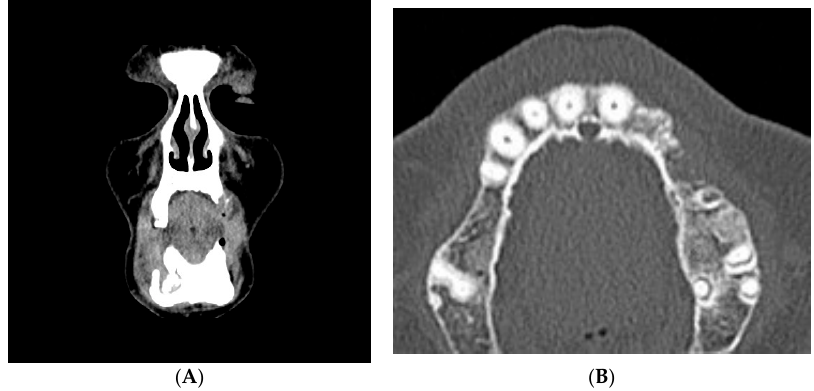
Figure 7. ( A , B ) CT scan dated February 2015. Coronal and axial cuts showing erosion of the left maxillary alveolar bone.